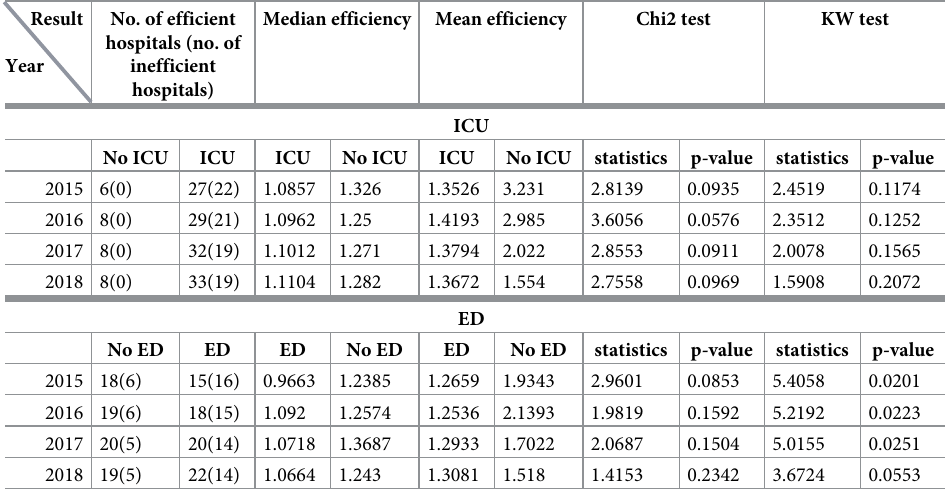
Table 7. Efficiency of public hospitals with respect to ED and ICU ( detailed approach).